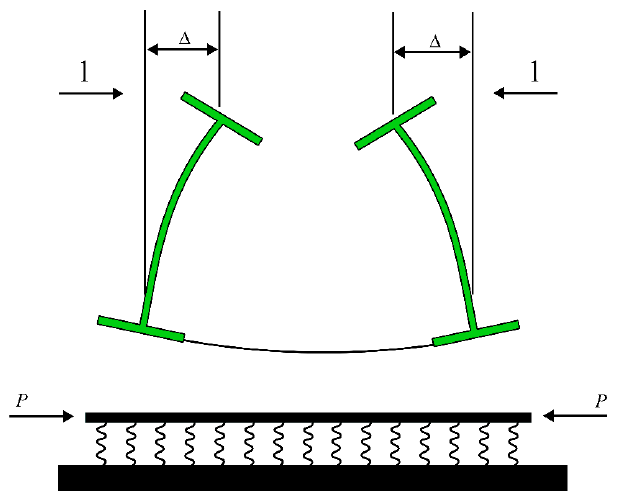
Figure 10. Inverted U-frame model. Adapted from Vrcelj and Bradford [26].